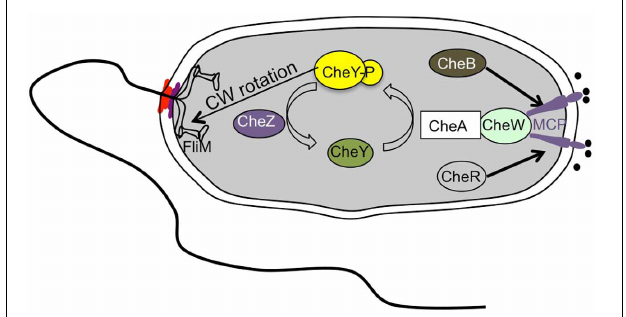
FIGURE 5 | Simplified scheme of the chemotaxis signal transduction cascade in Vibrio species. The scheme is drawn based on a previous report (Boin et al.,